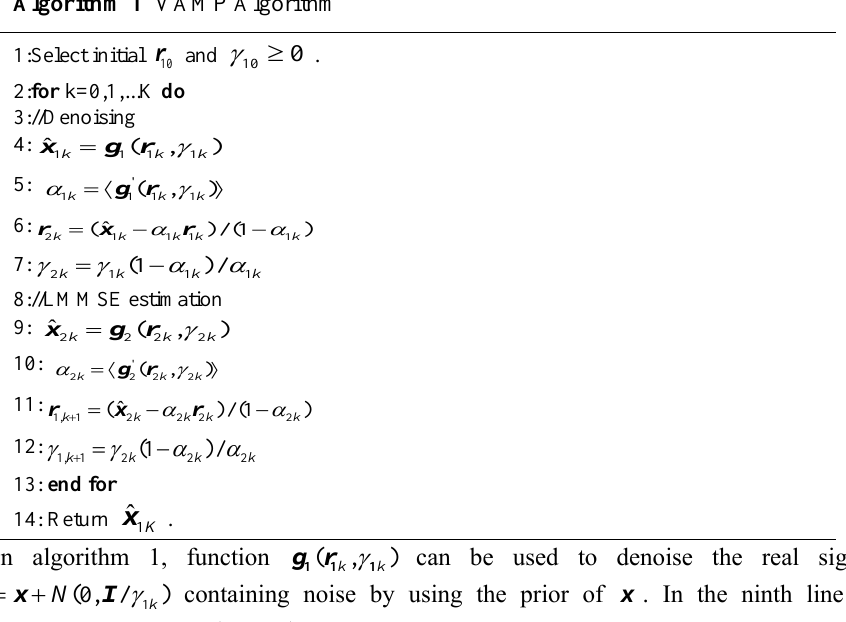
algorithm to estimate x under the pseudo